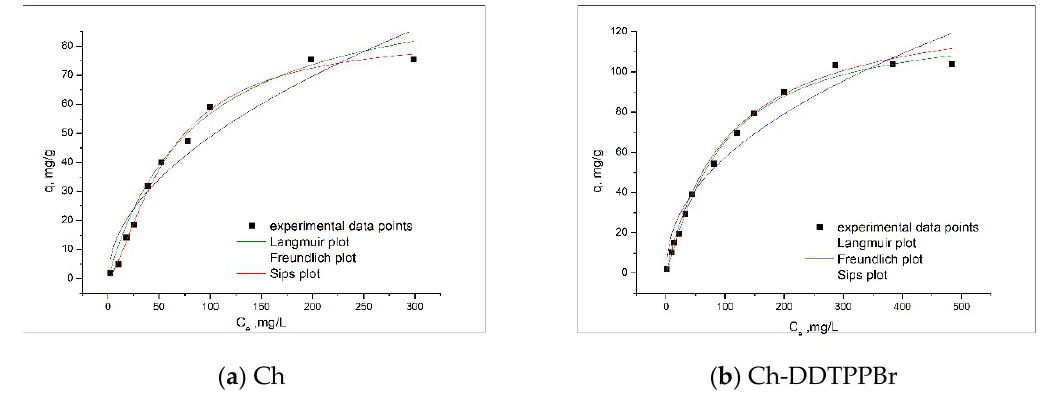
Figure 10. Isotherm model for adsorption of Ag (I) on the adsorbent materials ( a ) Ch; ( b ) Ch-DDTPPBr. Table 3. Parameters of isotherm model for adsorption of Ag(I) on the adsorbent materials.